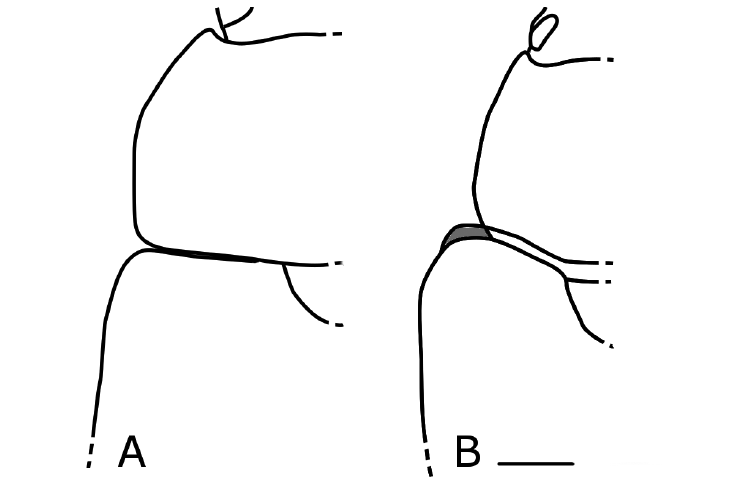
Figure 338. Mesepimeron of A Anomalorhina turrialbana B Strigoderma nodulosa . Scale bars: 1